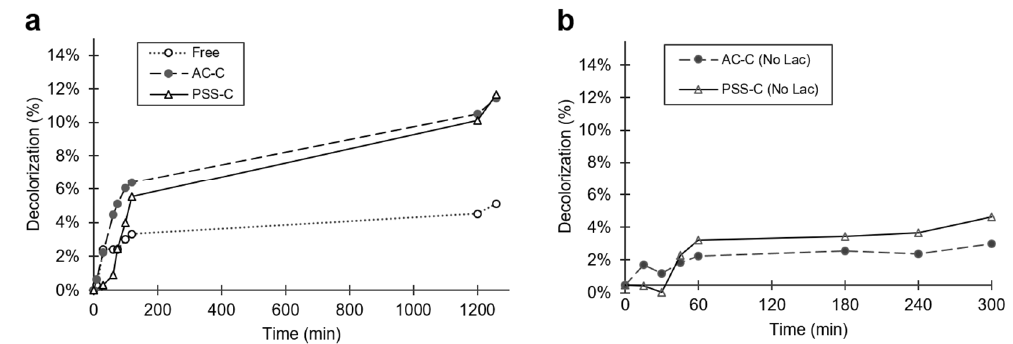
Figure 7. Time evolution of decolorization measurements of (a) free laccase, AC ‐ C, and PSS ‐ C and (b) AC ‐ C and PSS ‐ C without encapsulated laccase, in 100 mL Congo Red (70 mg L − 1 ) batch solutions. A linear regime of superior decolorization activity during the first 2 h was followed by a regime of approximately constant activity for the subsequent 18 h.